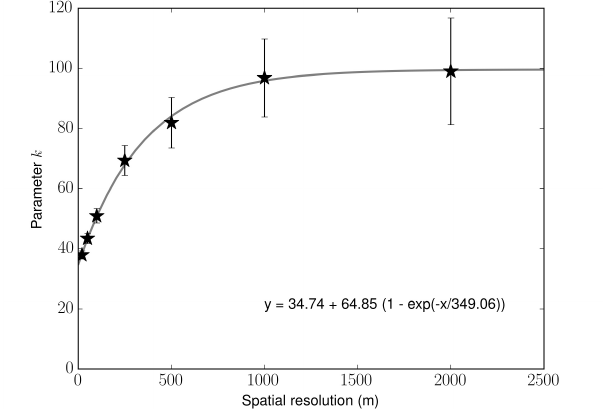
Figure 11. Observed variation of the parameter k with the spatial resolution. Fitted exponential curve is also